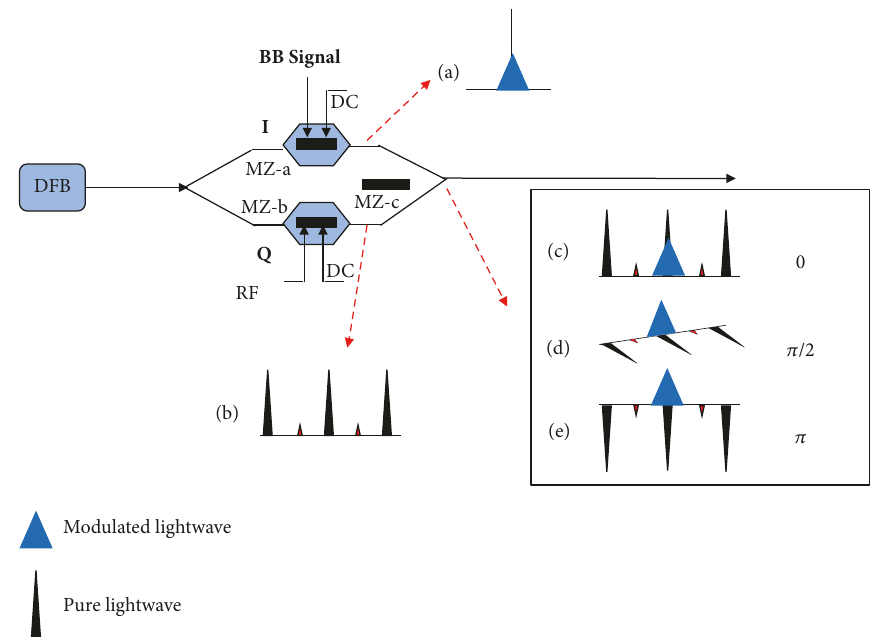
Figure 1: Principle of parallel Mach-Zehnder